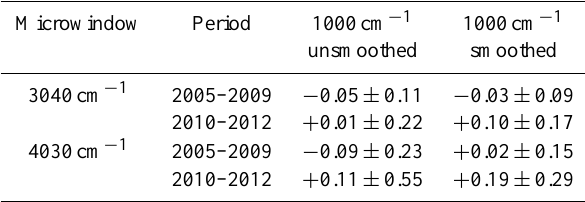
Table 5. Linear trends [%yr − 1 ] of the deseasonalised monthly rel- ative differences with respect to the 1000cm − 1 OTC data for the IFS 120 / 5HR time series (2005–2012): 1000cm − 1 unsmoothed (third column), and the 1000cm − 1 smoothed by the avks from the 3040cm − 1 and 4030cm − 1 regions (fourth column). The signifi- cance interval of the linear trends is estimated by assuming that the residuals are Gaussian and considering 2 σ standard deviations (i.e. 95% confidence level). Microwindow Period 1000cm − 1 1000cm − 1